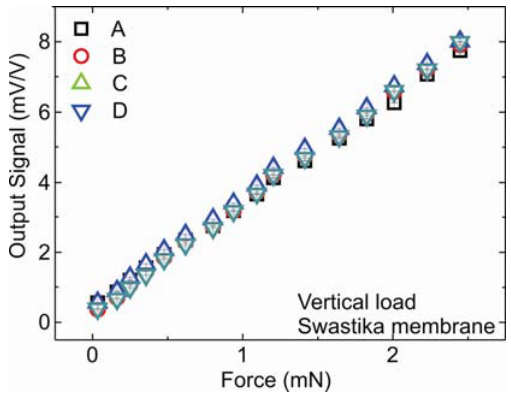
Figure 5 . Output voltage vs force plot for swastika membrane.